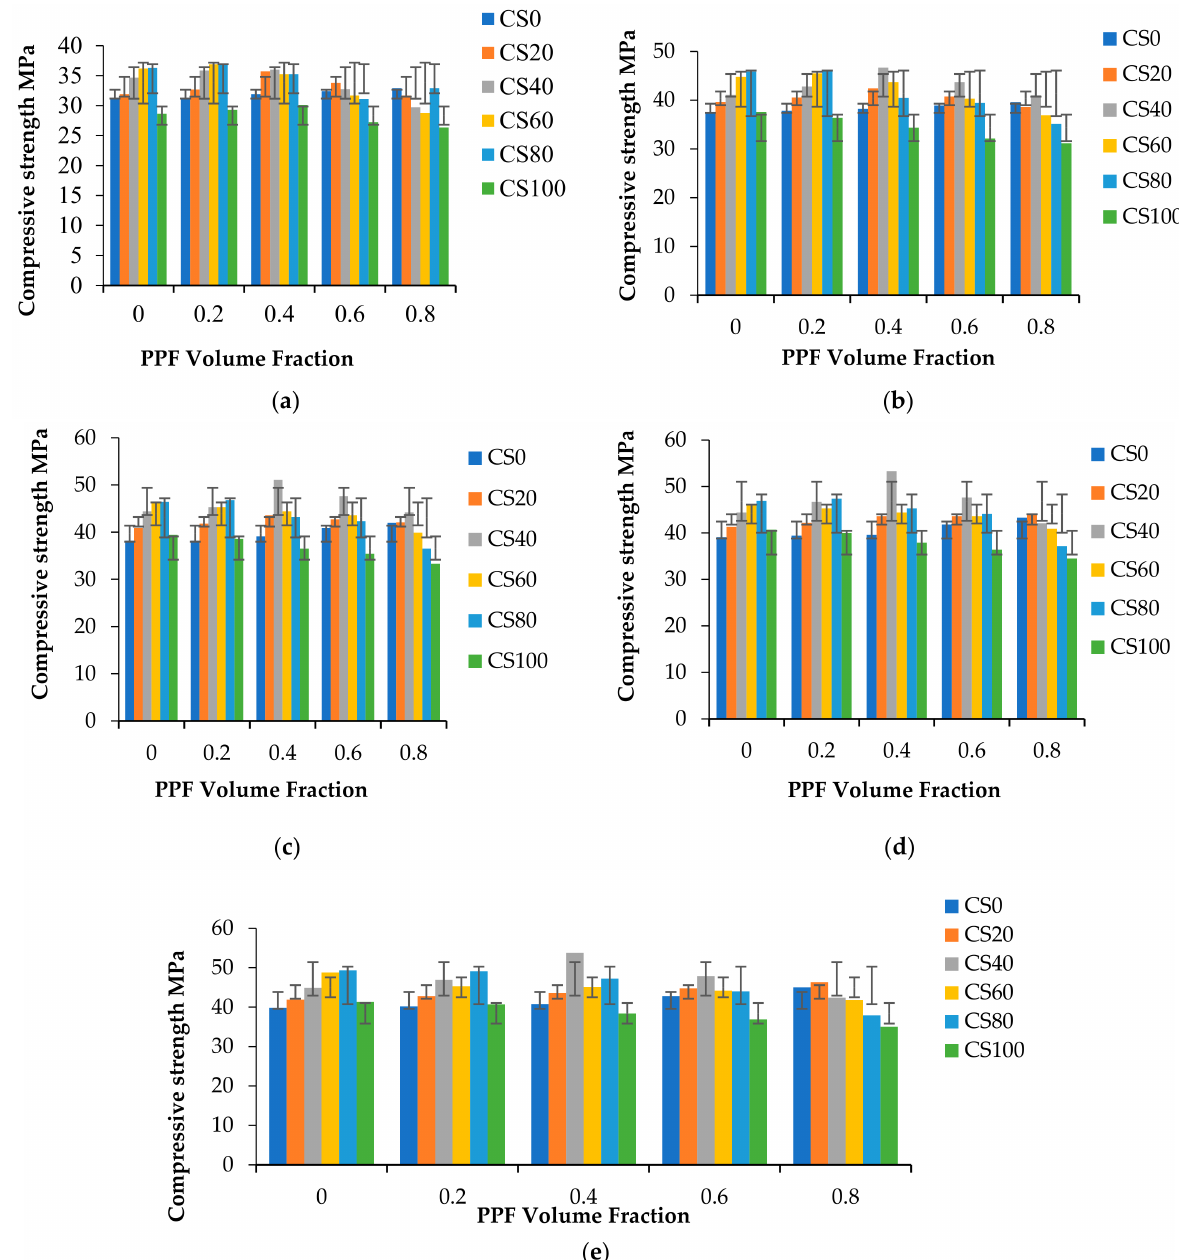
Figure 9. Compressive strength of concrete at 7, 28, 56, 90, and 180 days. ( a ) Compressive strength at 7 days; ( b ) Compressive strength at 28 days; ( c ) Compressive strength at 56 days; ( d ) Compressive strength at 90 days; ( e ) Compressive strength at 180